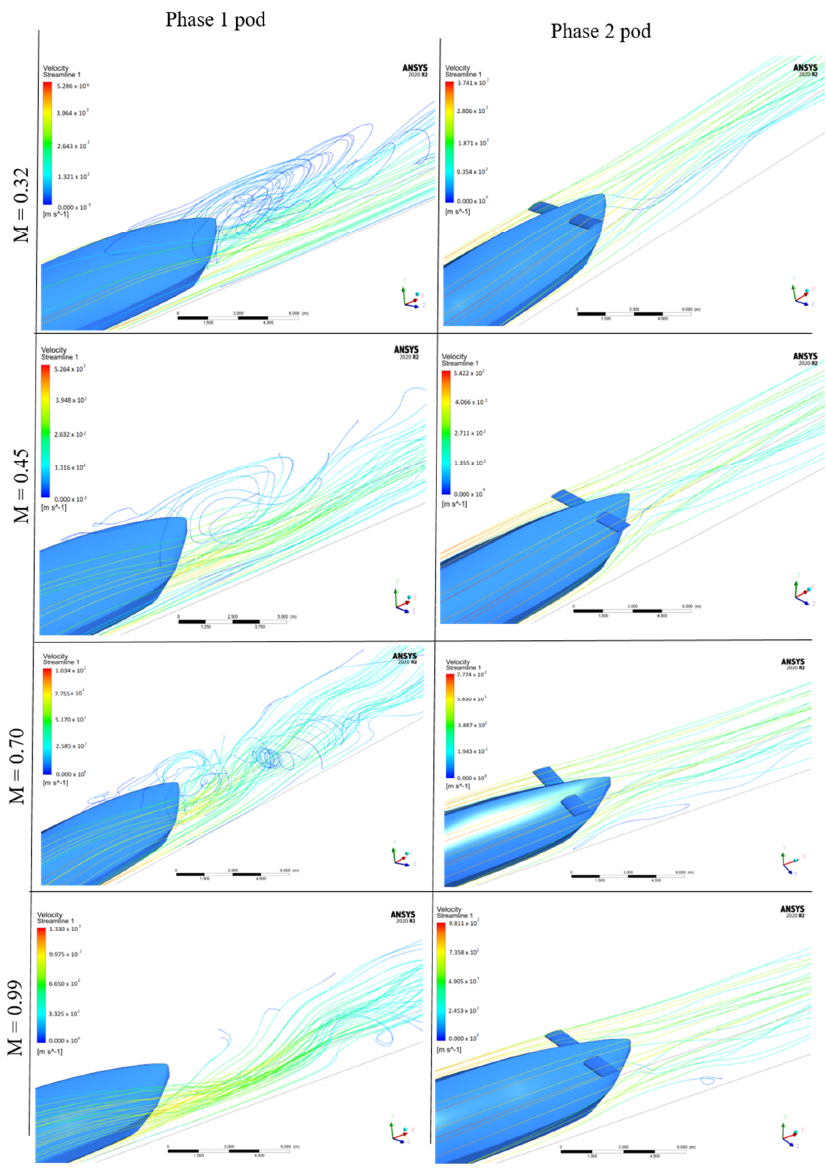
Figure 10. Comparison of the stream lines around the two pods. It was observed that the phase 2 pod led to fewer eddy currents compared to the phase 1